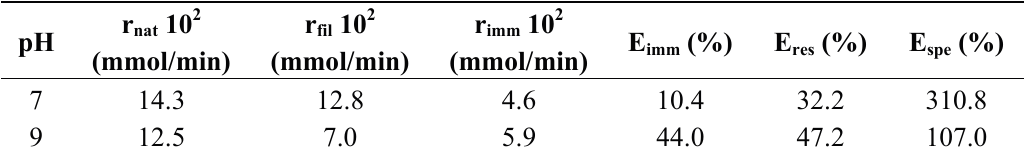
Table 2. Percentage of immobilized enzyme, E activity of the immobilized enzyme, E catalytic activity (mmol/min) of the free native enzyme, r the immobilization process, r linker obtained by reaction of 4-aminobenzylamine and terephtaldialdehyde. The lipase immobilization has been carried out at pH 7 and 9 and at 30